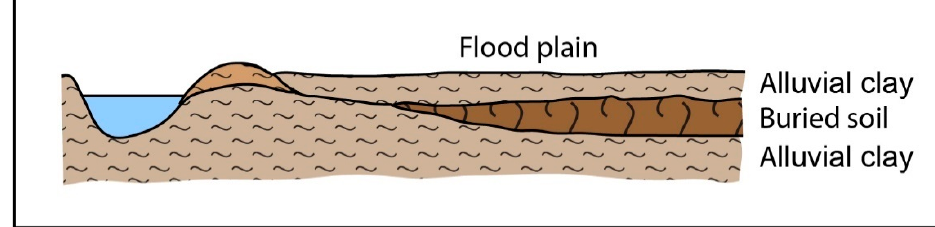
Figure 3. Buried soil within stratified alluvial flood plain sediments, indicating a break in the deposition of flood plain sediments long enough for a soil to develop. Based on the author’s observations immediately east of the Nile in northern